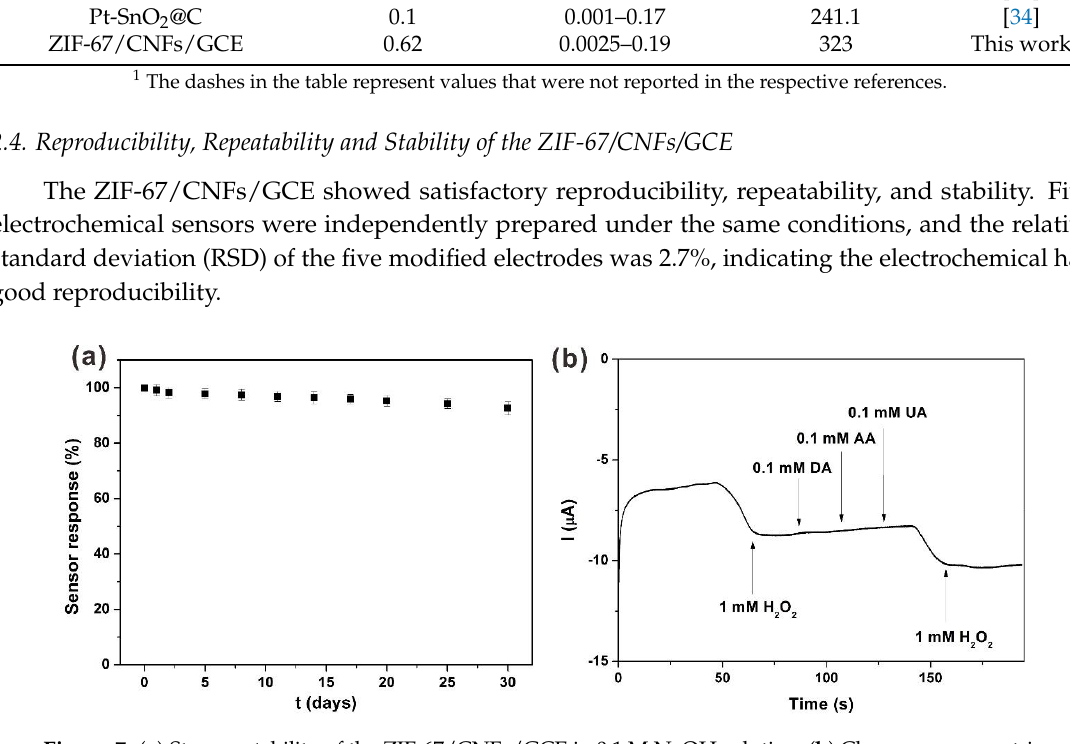
Figure 7. ( a ) Storage stability of the ZIF-67/CNFs/GCE in 0.1 M NaOH solution; ( b ) Chronoamperometric responses of ZIF-67/CNFs/GCE in 0.1 M NaOH solution at an applied potential of − 0.2 V with 1mM H 2 O 2 + 0.1 mM DA + 0.1 mM AA + 0.1 mM UA.